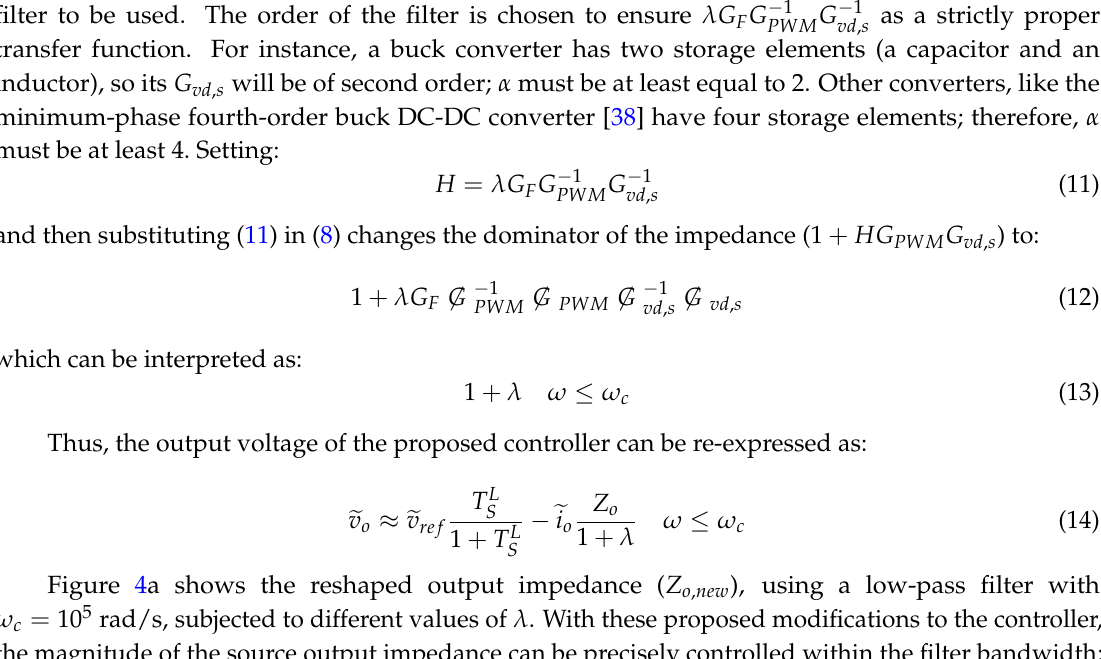
Z o ; and ( b ) demonstrates the selection of ω i | |